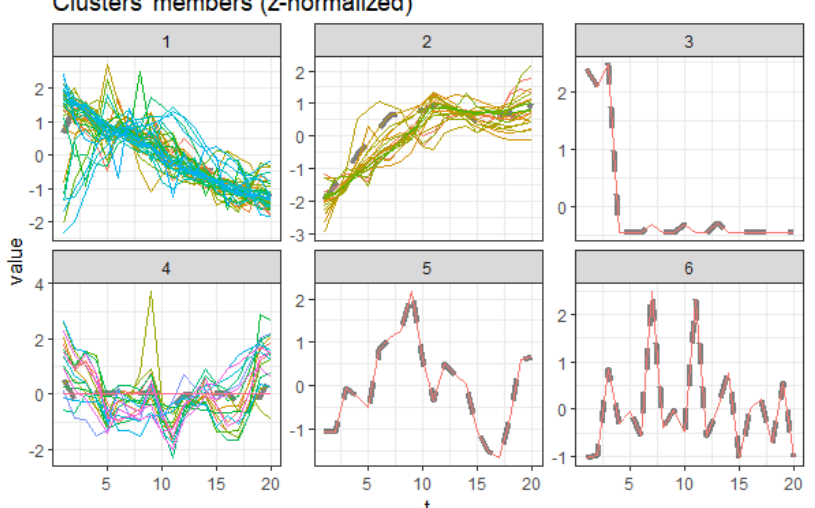
Figure 17. Centroid extraction of males aged over 60.